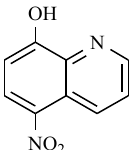
The Mechanism of the Antibacterial Action of